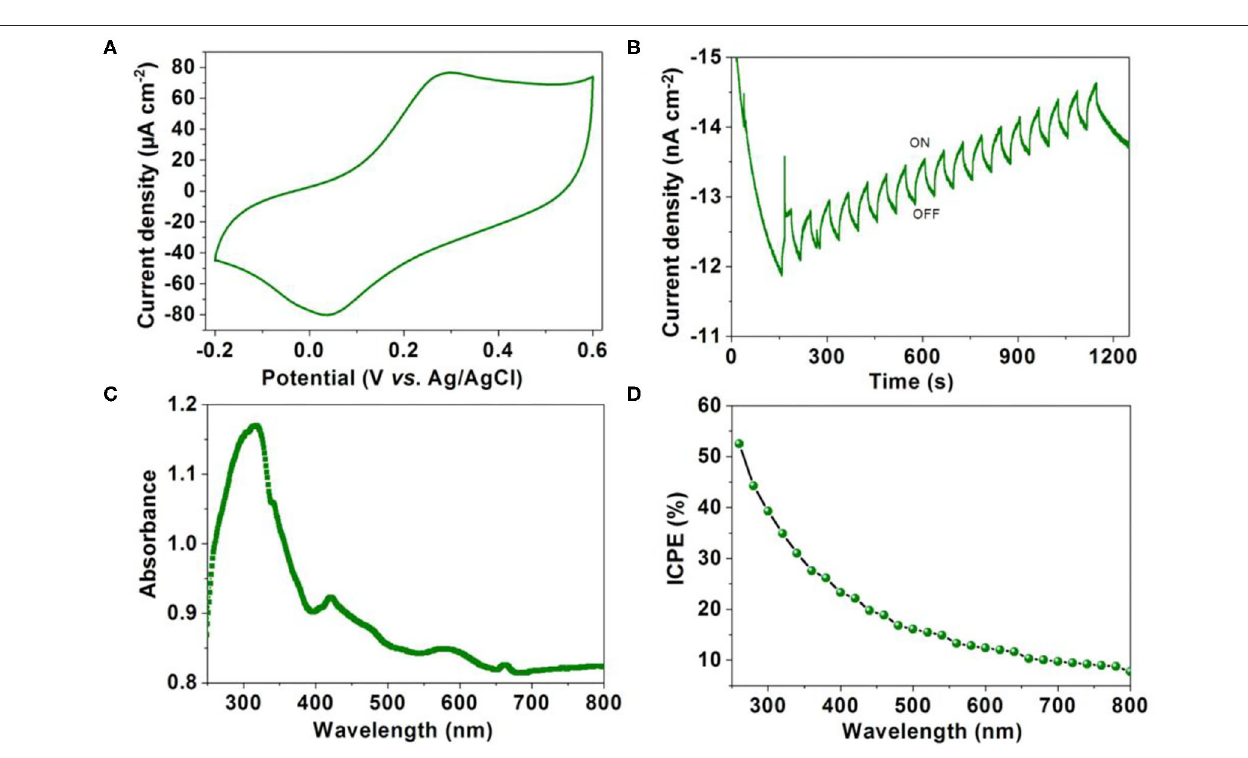
FIGURE 5 | (A) Cyclic voltammograms cuves of 1 modified ITO electrode measured in 0.5M Na 2 SO 4 aqueous solution. (B) Transient current density–time curve of 1 at a bias potential of − 0.5V with the periodic on-off cycles of illumination. (C) The UV-visible absorption spectrum of 1 . (D) Action spectrum for IPCE vs. wavelength of 1